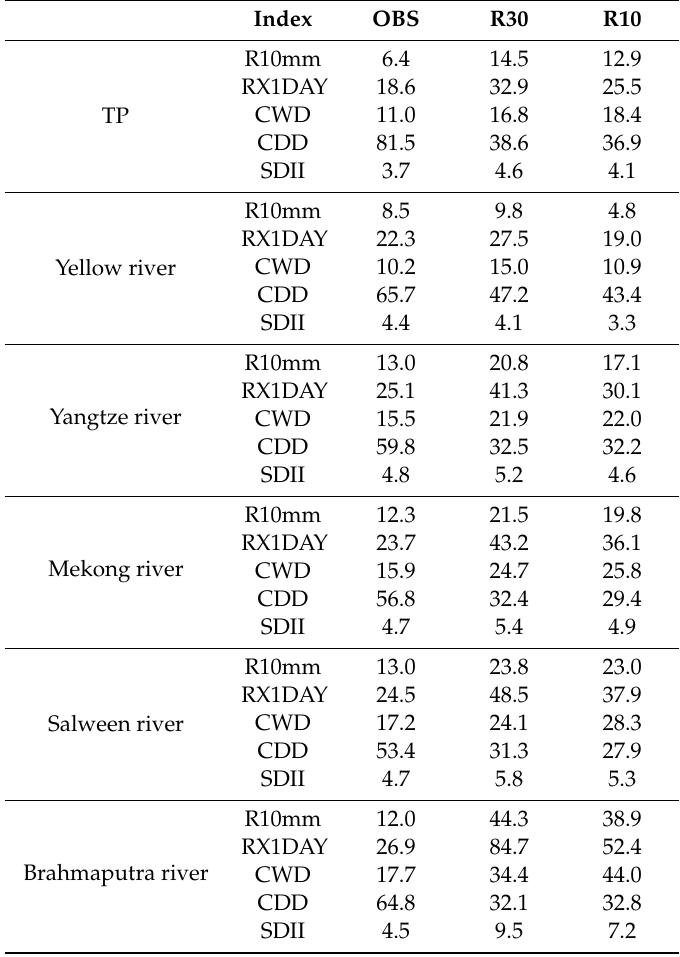
Table 3. Observation and area averages of simulated extreme precipitation indicators for 1980 −